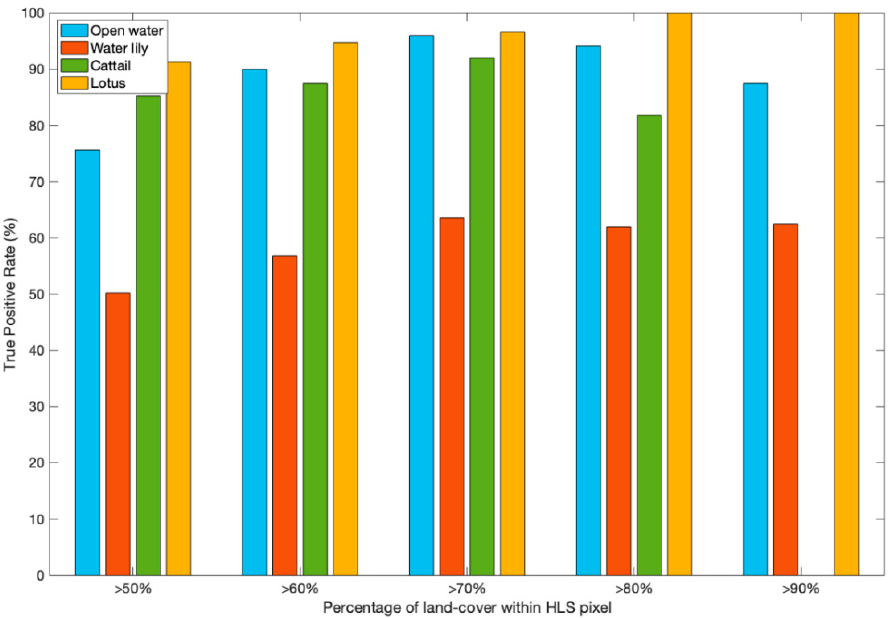
Figure 5. HLS classification accuracy for mixed pixels. The true-positive classification accuracy of the HLS classification of 2017 compared to the classified WorldView-3 image. A classification was considered correct when the majority of the WorldView-3 pixels within the area of an HLS pixel were classified as the same type as the HLS pixel. Colors correspond to the patch type of the HLS pixel. Groups of columns relate to the fractional cover of that majority patch type, from >50% (representing highly mixed pixels) to >90% (representing pure pixels), in increments of